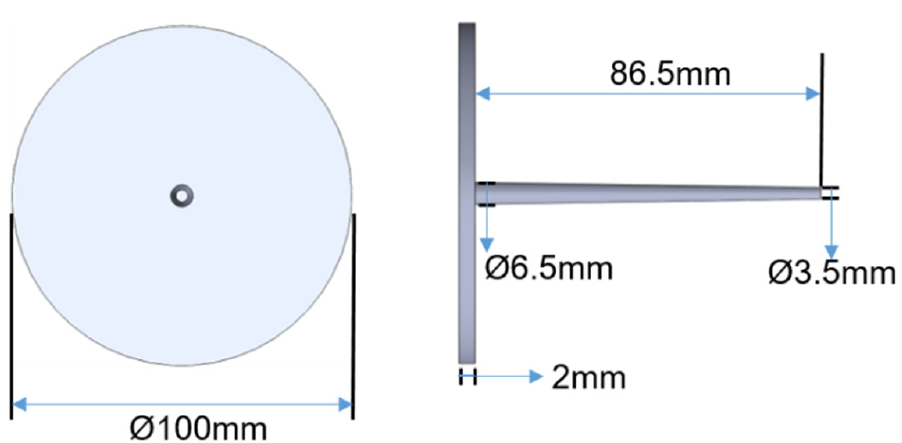
Figure 6. The size of the thin plastic disk sample .